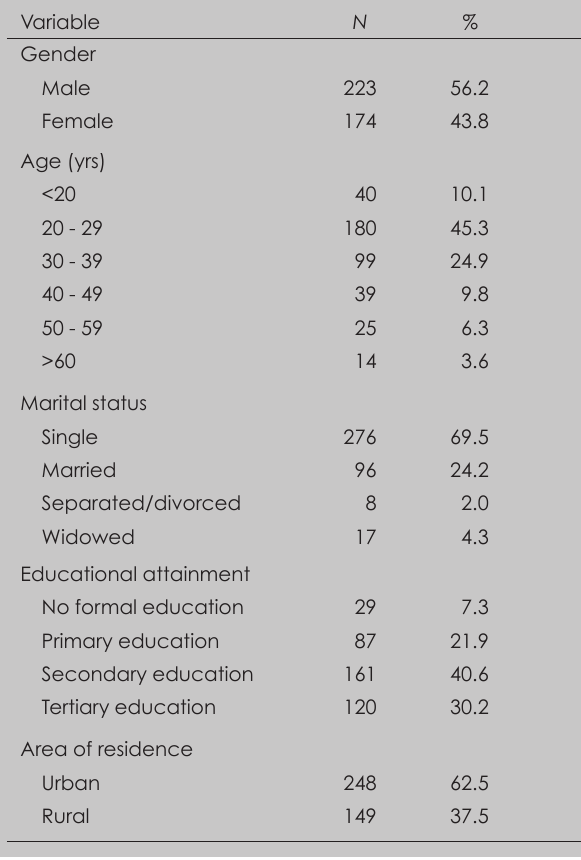
Table I. Socio-demographic variables of respondents Table II. Hospital visit characteristics of respondents